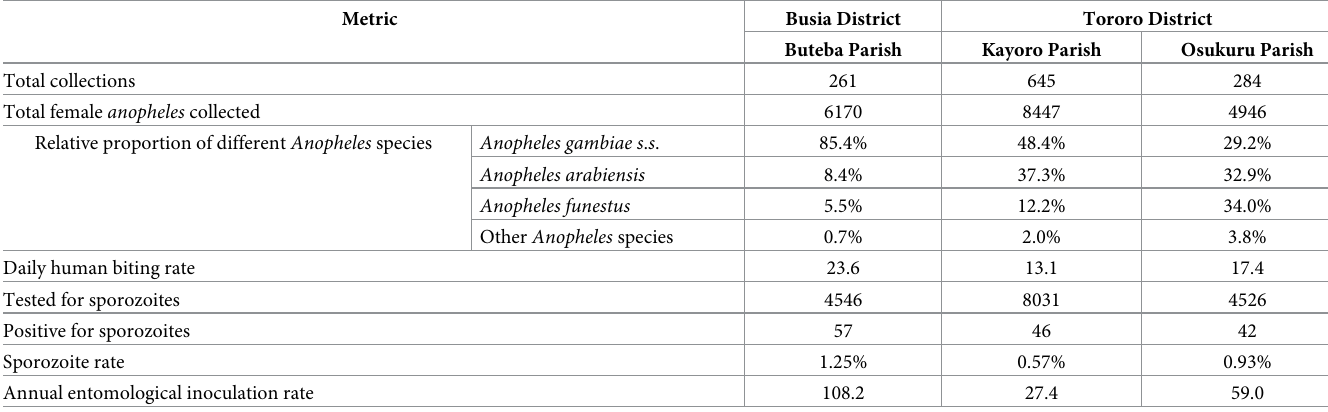
Table 2. Entomological metrics from bi-weekly CDC light trap collections stratified by parish.